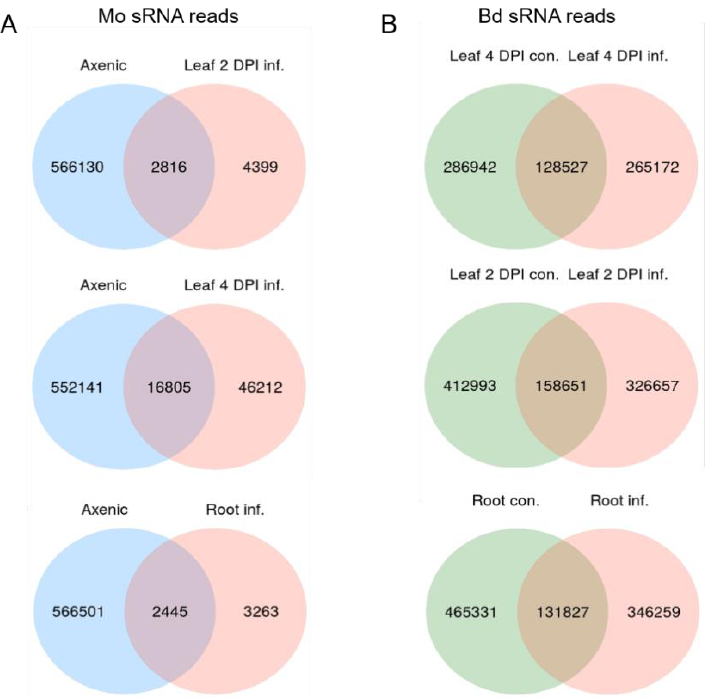
Figure 8. Venn diagrams of unique filtered sRNAs reads from M. oryzae and B. distachyon . ( A ) Venn diagram of Mo sRNA reads (18–32 nt) from axenic culture and Mo-infected Bd leaves (2 DPI, 4 DPI) and roots (4 DPI). ( B ) Venn diagram of Bd sRNA reads (18–32 nt) in non-infected and Mo-infected Bd leaves.